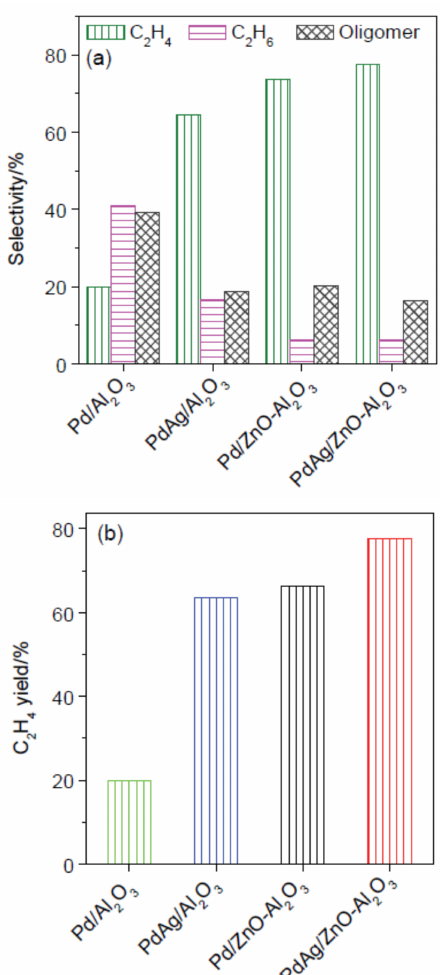
Figure 20. Product selectivities ( a ) and C 2 H 4 yields ( b ) for PdAg/ZnAl catalysts, 180 min at 90 ◦ C (reproduced with permission from [283]. Copyright 2017 WILEY-VCH Verlag GmbH & Co.